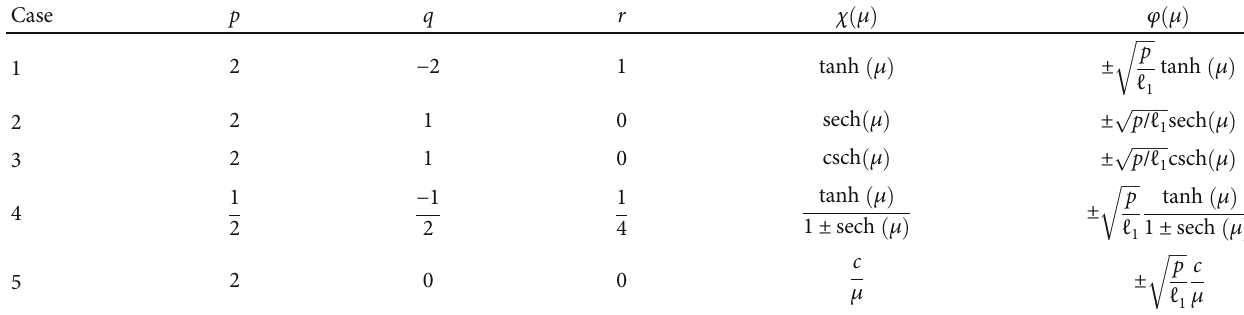
Table 3: All possible solutions for wave Equation (14) when p > 0 and m ⟶ 1 .